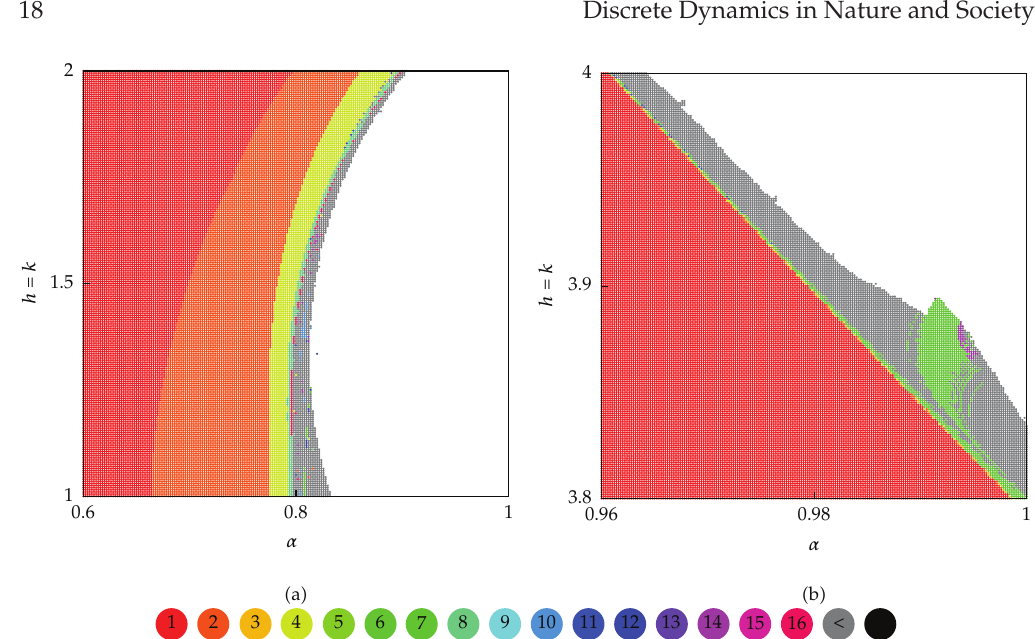
Figure 5: Bifurcation diagrams in the (cid:2) α,h (cid:3) plane for the three-group model (cid:2) a (cid:3) and for the three-firm model (cid:2) b (cid:3) .